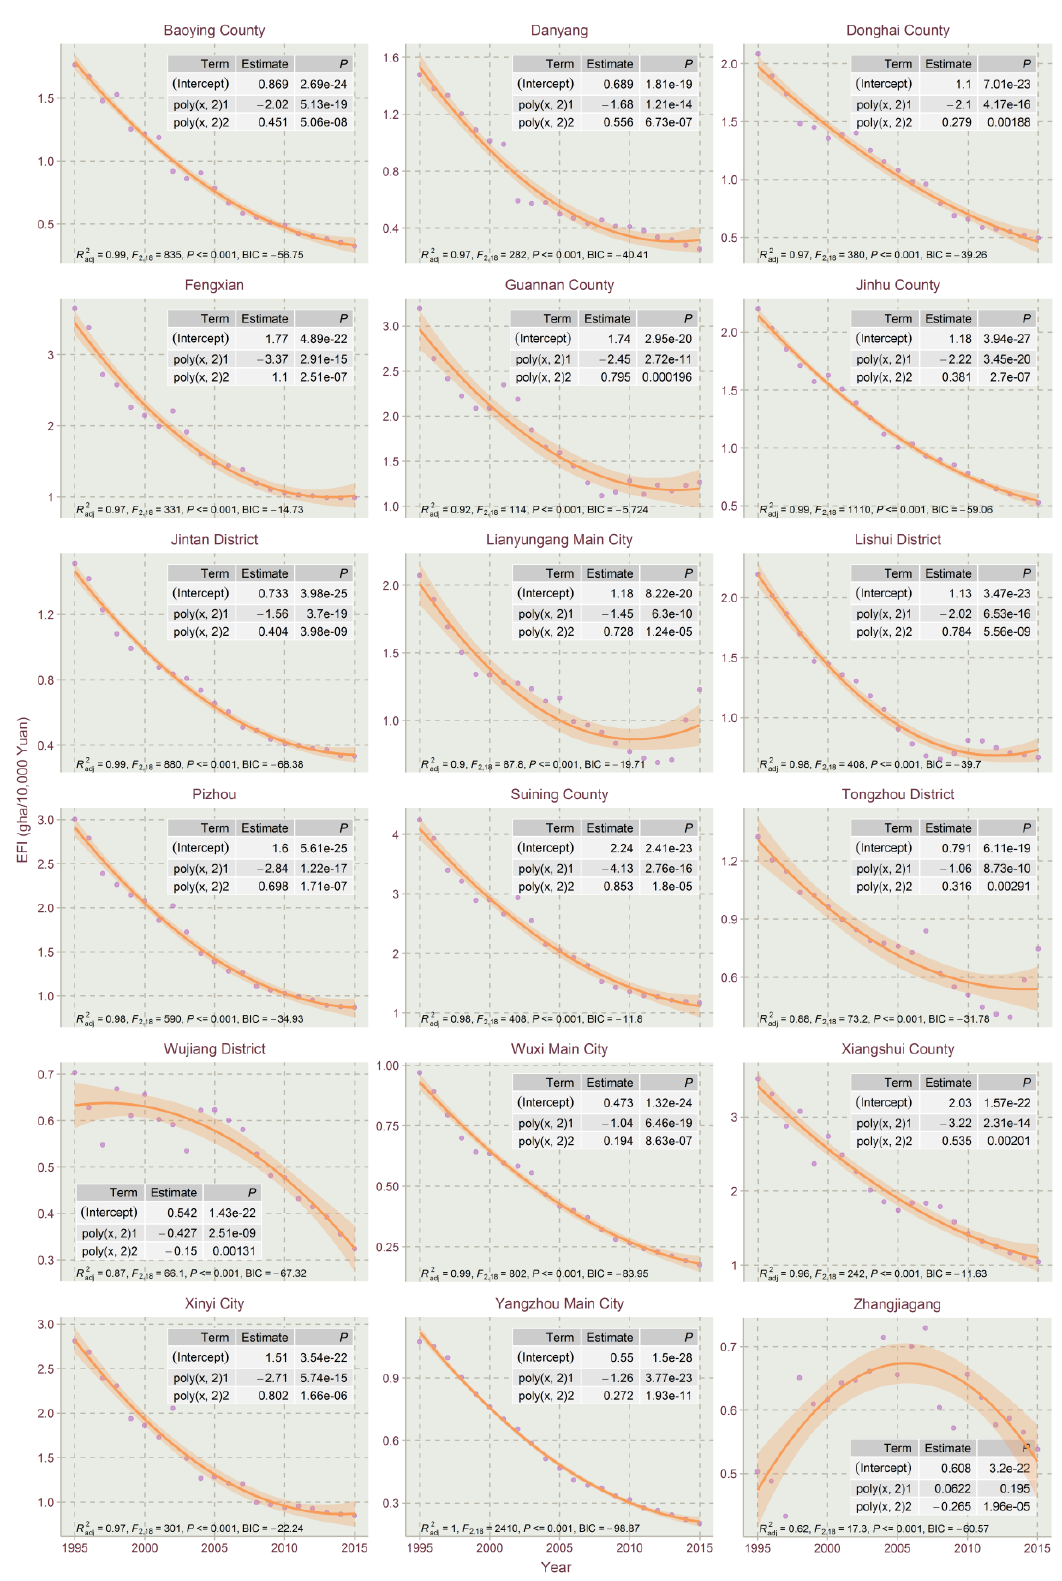
Figure 5. Quadratic orthogonal curve fitting of EFIs of Jiangsu Province for 1995–2015 (Part 1).